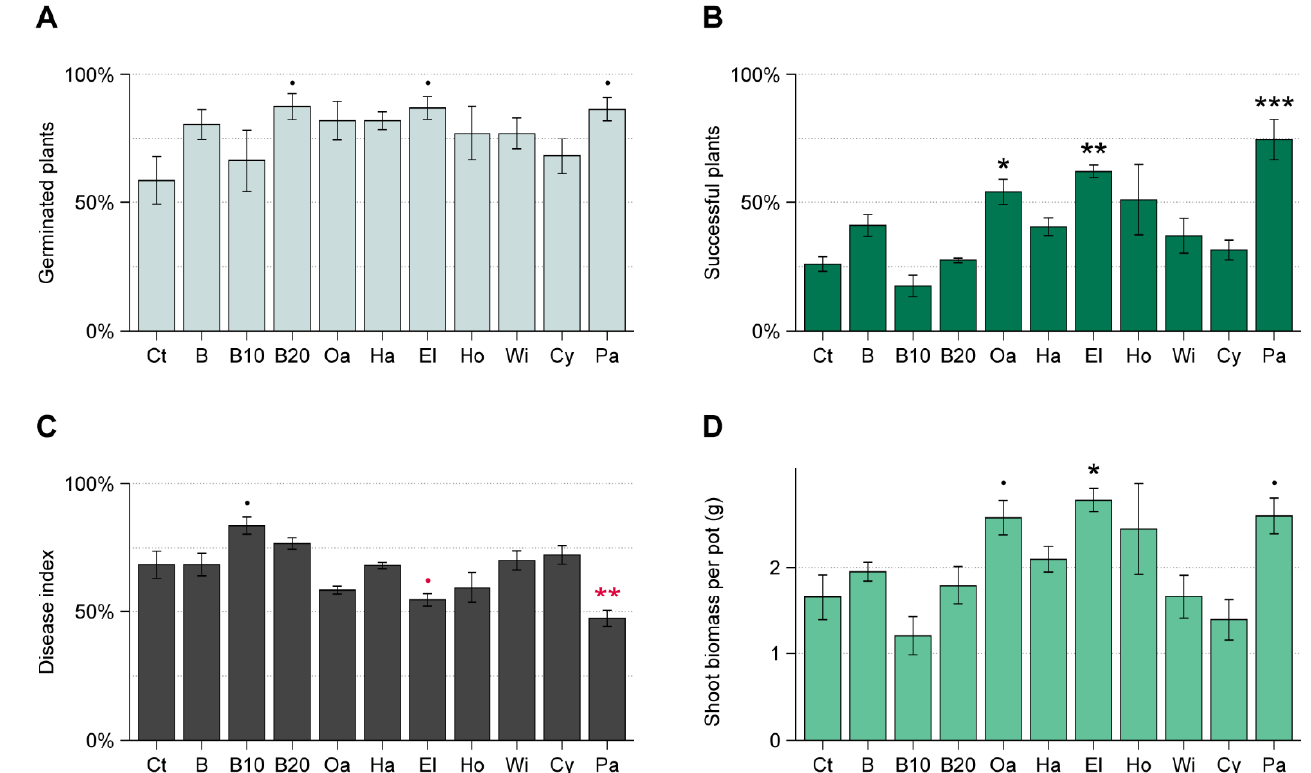
Figure 5. Performance of beetroot seedlings in Rhizoctonia -infected soil amended with sawdust types and paper pulp (WT experiment). Soil treatments are indicated as: Ct = control, B = beech sawdust, B10 = 10% pre-decomposed beech, B20 = 20% pre-decomposed beech, Oa = oak, Ha = hazel, El = elder, Ho = holly, Wi = willow, Cy = cypress, Pa = paper pulp. ( A ) Percentage of germinated seeds; ( B ) percentage of seeds that resulted in successful plants; ( C ) seedling disease severity index per pot; ( D ) total aboveground biomass per pot. All measurements are shown as mean ± se , n = 5 for each treatment. Significant differences between each treatment and the control (Dunnett’s test) are indicated as • 0.1 > p > 0.05; * 0.05 > p > 0.01; ** 0.01 > p > 0.001, *** p < 0.001. Black and red symbols indicate significant increase and decrease, respectively, as compared to the control.